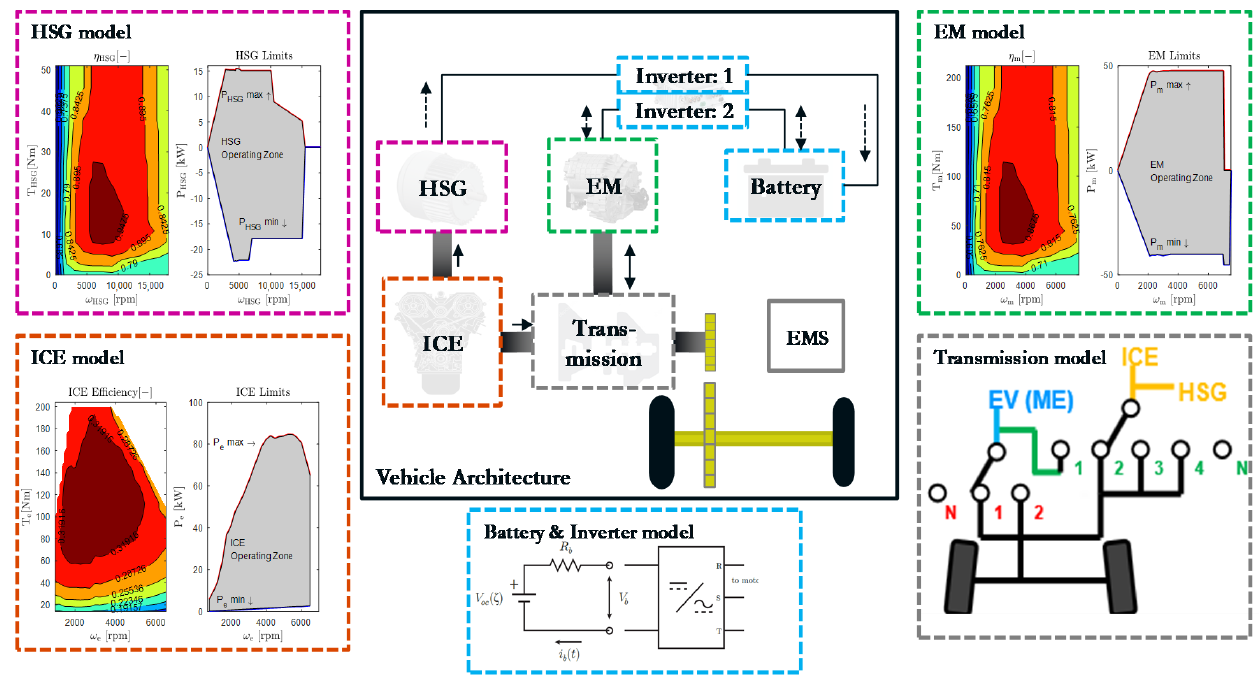
Figure 2. Virtual components of the hybrid